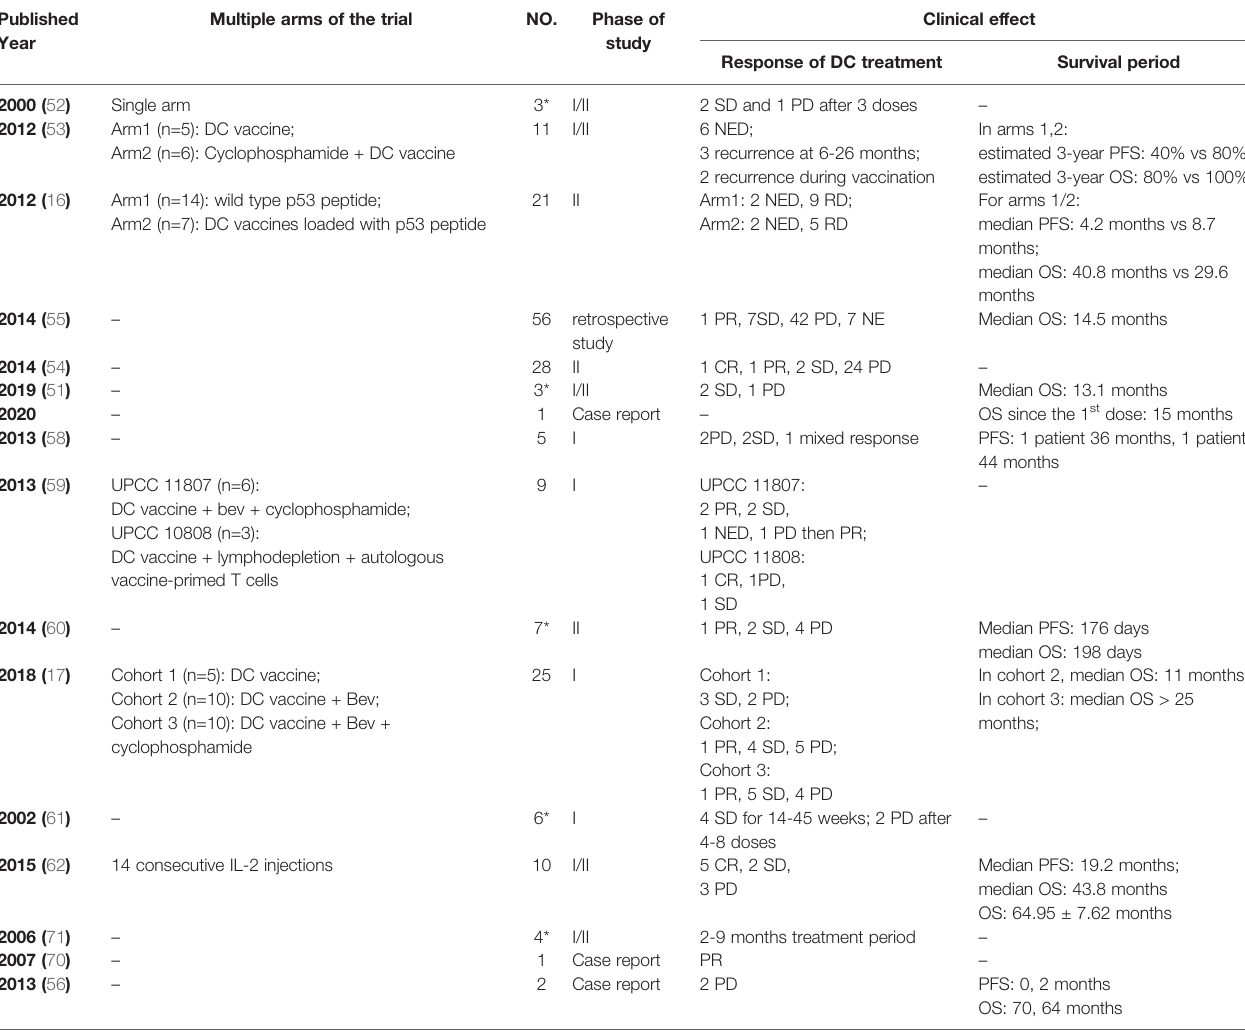
TABLE 2 | The clinical trials of DC vaccines in ovarian cancer. Published